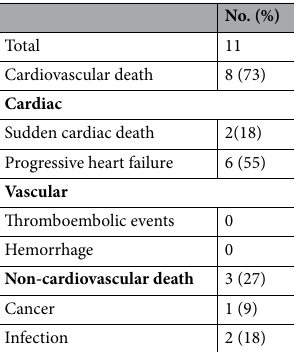
Table 3. Causes of death in the higher-risk patients without improvement in peak V ̇